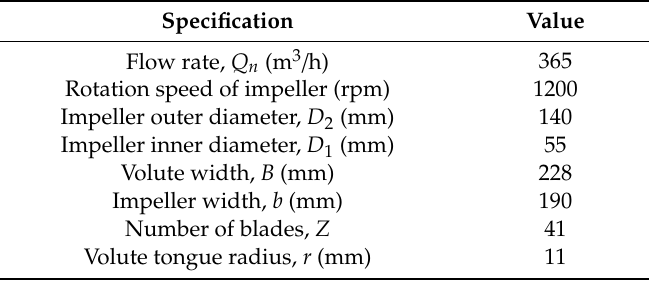
Figure 1. Baseline model. ( a ) fan model; ( b ) impeller and volute; ( c ) definition of radius of volute tongue. Table 1. Specifications for the baseline Sirocco fan.